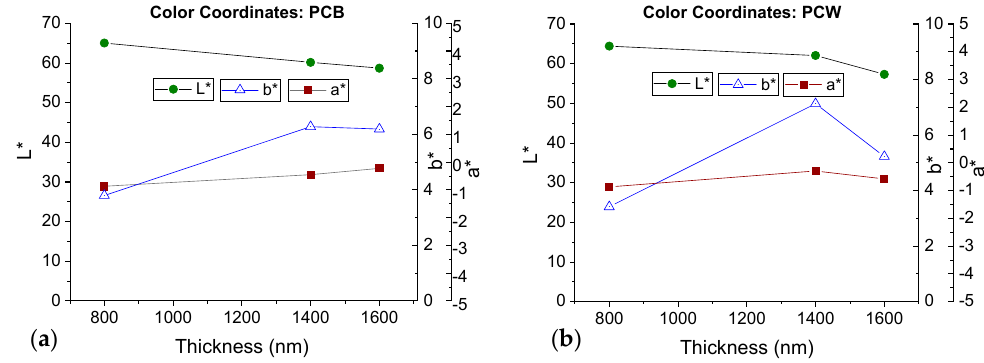
Figure 10. CIE-L*a*b* color coordinates of Cr coatings with various thicknesses for: ( a ) PCB and ( b ) PCW.